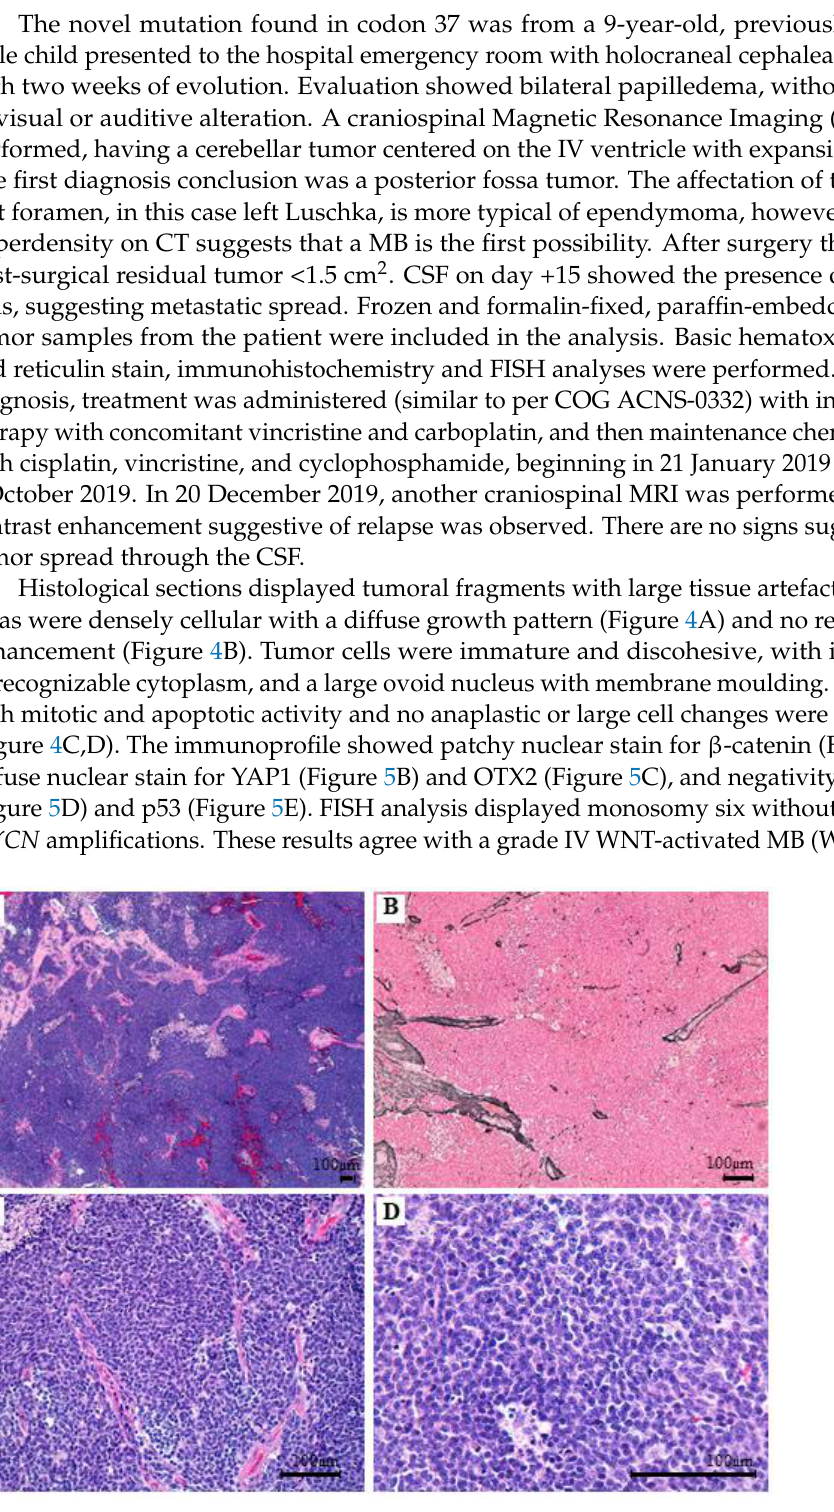
Figure 4. Hematoxylin-eosin staining of tumor specimen. Histological sections display tumoral ( A ): Hematoxylin-eosin stain, 40× magnification) and no reticulin net enhancement ( B ): Reticulin stain, 100× magnification). No anaplastic or large cell changes are noticeable. ( C ): Hematoxylin-eosin, 200× magnification and ( D ): Hematoxylin-eosin, 400× magnification).